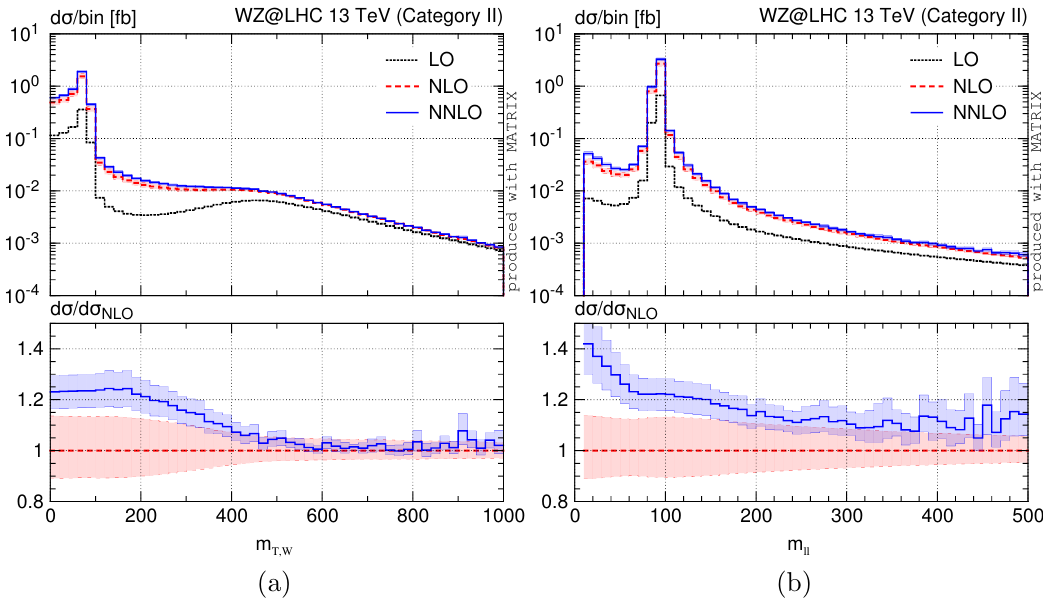
Figure 15 . Distributions with respect to (a) m T;W and (b) m ‘‘ in the (cid:12)ducial phase space with an additional p miss > 200 GeV cut (Category T